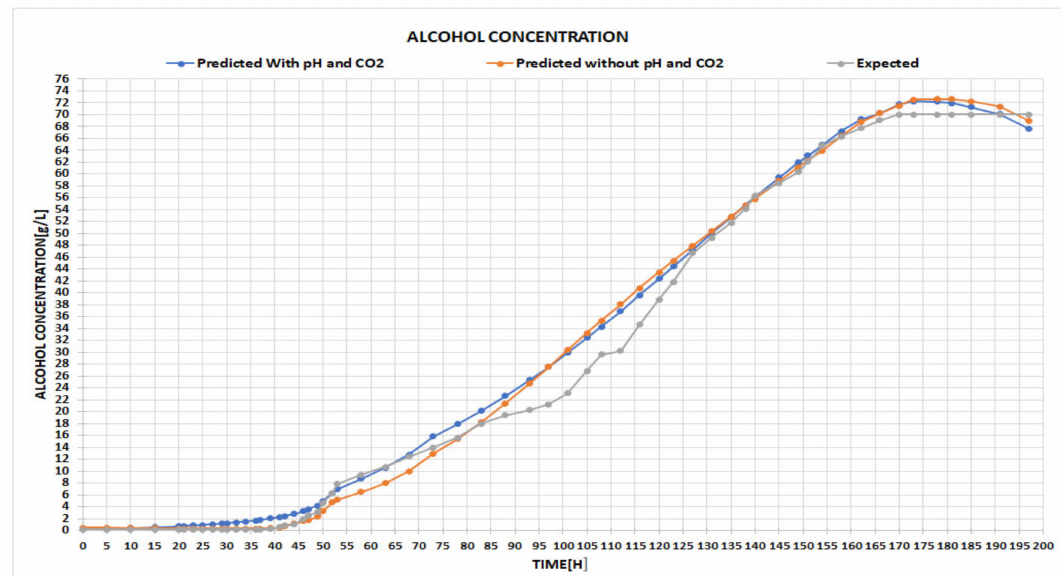
Figure 12. Alcohol prediction, based on different types of data sets.